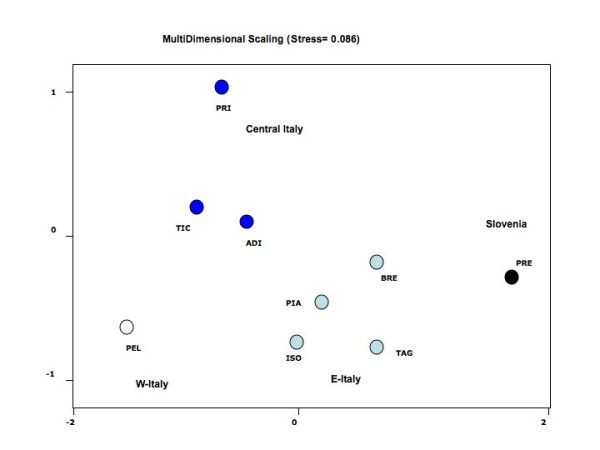
Plots from Multi-Dimensional Scaling analysis based on Cavalli-Sforza and Edwards (1969) chord distance. Samples labelled as in Figure 1.